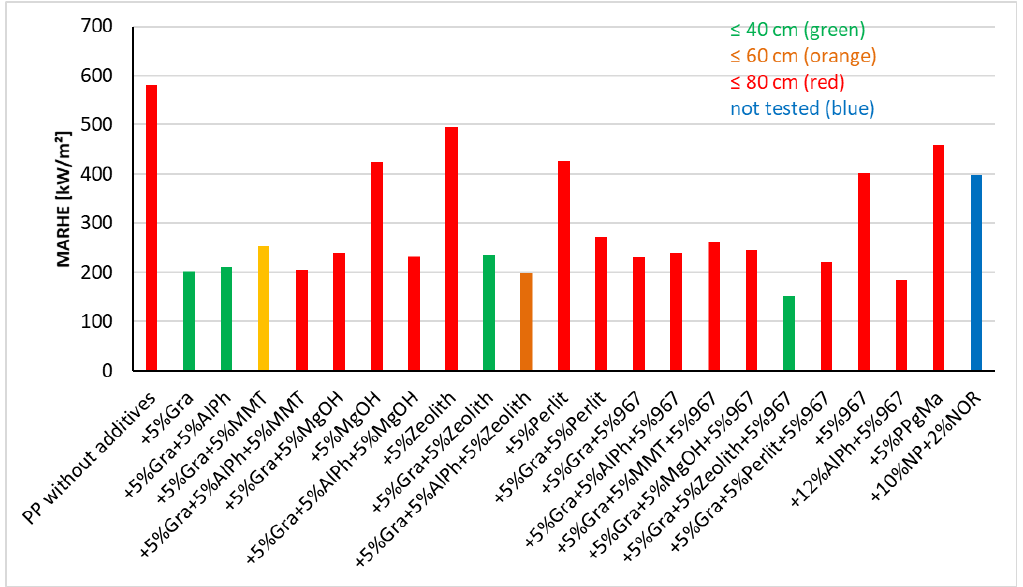
Figure 19. Comparison of the cone results (MARHE) with the burned lengths according to Schlyter test (shown in colour) for additivated PP.